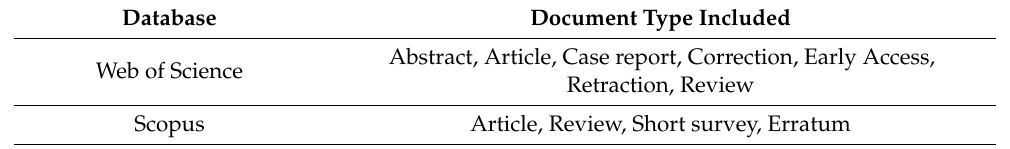
Table 1. Databases and document types included in the